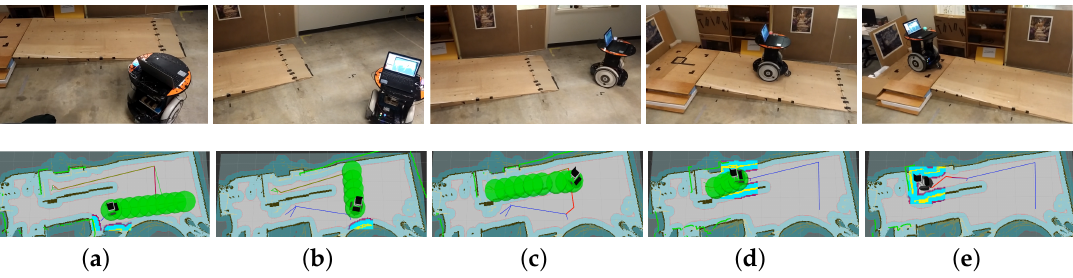
Figure 14. Robot autonomous navigation example in real environment (Task 4 in Table 3). ( a , b ) The robot is making a turn to approach the slope; ( c ) the robot is to climb the slope; ( d ) The robot is climbing the slope; ( e ) The robot reaches the target above the